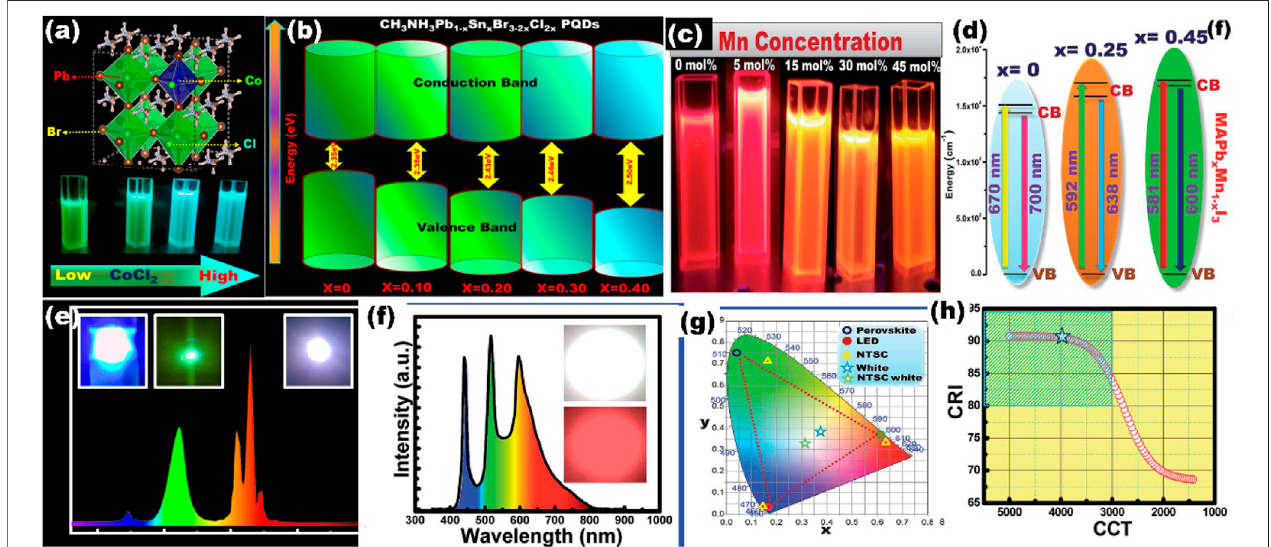
FIGURE 15 | Different Pb-less PQD-based backlight LEDs, (A) MAPb 1-x Co x (Br/Cl) 3 ( x = 0 – 0.50) PQD structure, and its change in color from green to cyan with CoCl 2 incorporation into MAPbBr 3 (Singh et al., 2021a), (B) MAPb 1-x Sn x (Br/Cl) 3 ( x = 0 – 0.50) PQD energy band diagram (Singh et al., 2020), (C,D) MAPb 1-x Mn x I 3 PQD colloidal solutions under UV light and energy band diagram (Singh et al., 2019), (E) white LED full spectra of MAPb 1-x Zn x Br 3 ( x = 0 – 0.50) PQD (Singh et al., 2021b), and (F – H) MAPb1-xMnxI 3 ( x =0 – 0.60)PQD-basedred LEDs,full-coloremitter,CIE spectra, andCRI,and CCTvalueofthePQD-basedbacklight lightconvertor(Singh et al.,